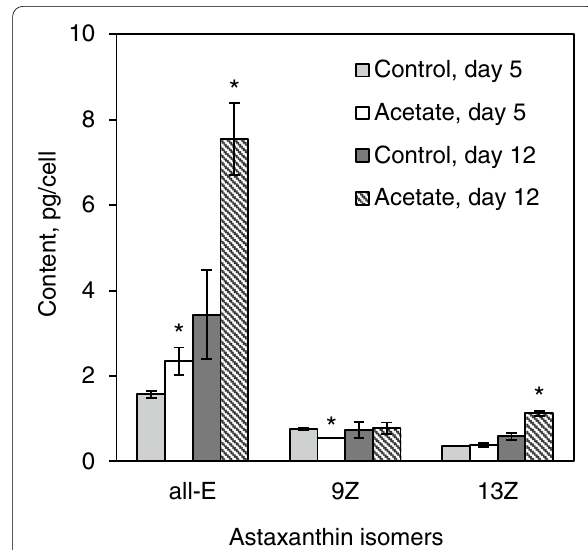
Fig. 7 Content of specific astaxanthin isomers in H. pluvialis cells after 5 and 12 days of cultivation under stress conditions